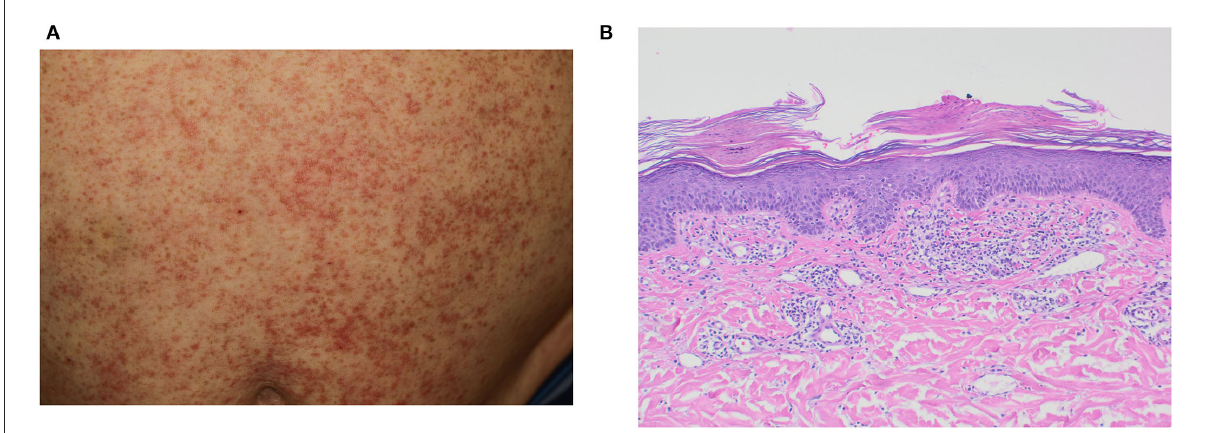
FIGURE1 Clinical and histopathological presentation of patient 3. (A) guttate-like sharply confined erythematosquamous papules, (B) parakeratosis and acanthosis with a patch-like lymphohistiocytic inflammatory infiltrate in